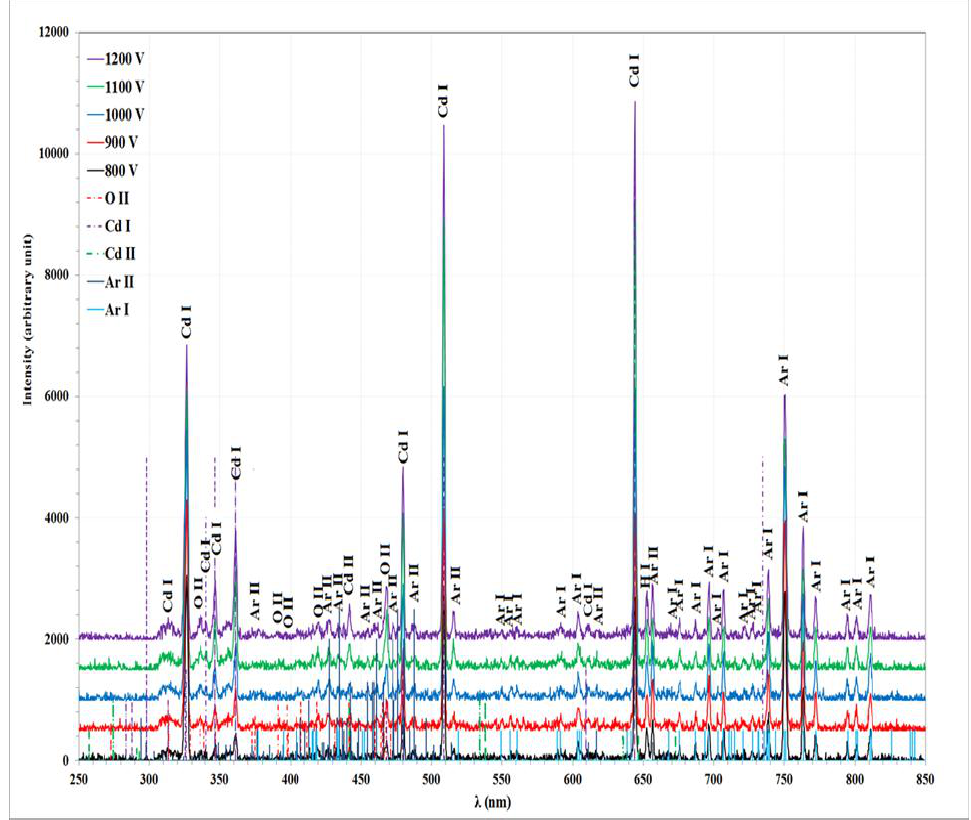
Fig. 3: OES to plasma diagnostic between intensity as a function of wave length for different voltage (800-1200)